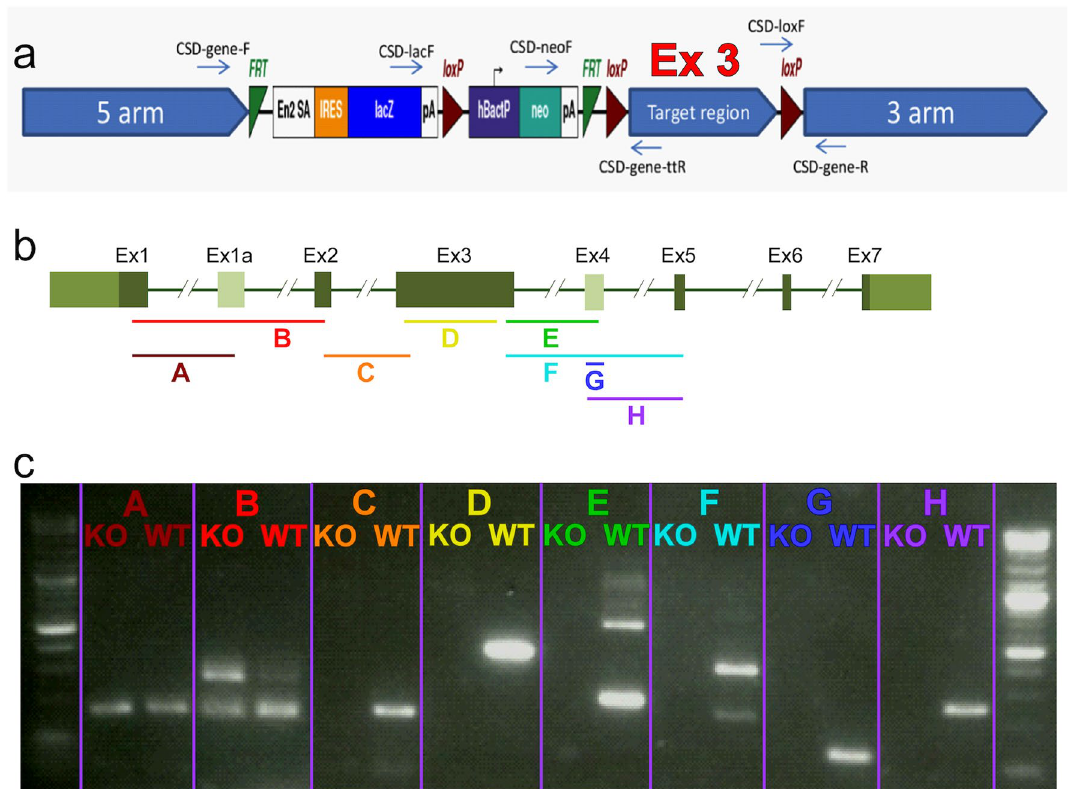
Figure 1. Fam161a knock out cassette and RNA expression in the mouse retina. ( a ) Schematic representation of the cassette (edited based on https ://www.komp.org/Produ ctShe et.php?clone ID=63510 2) inserted into the mouse genome, targeting exon #3 of Fam161a (as provided by the KOMP company). ( b ) Schematic representation of the Fam161a structure. Dark green are exons that appear in all the transcripts, light green are alternative exons that appear in part of the transcripts. Color fragments represent the predicted RNA products in a specific PCR reaction. ( c ) RT-PCR products of different fragments of the Fam161a RNA in WT and Fam161a tm1b/tm1b mice. Each color represents a different fragment which fits the color on the top